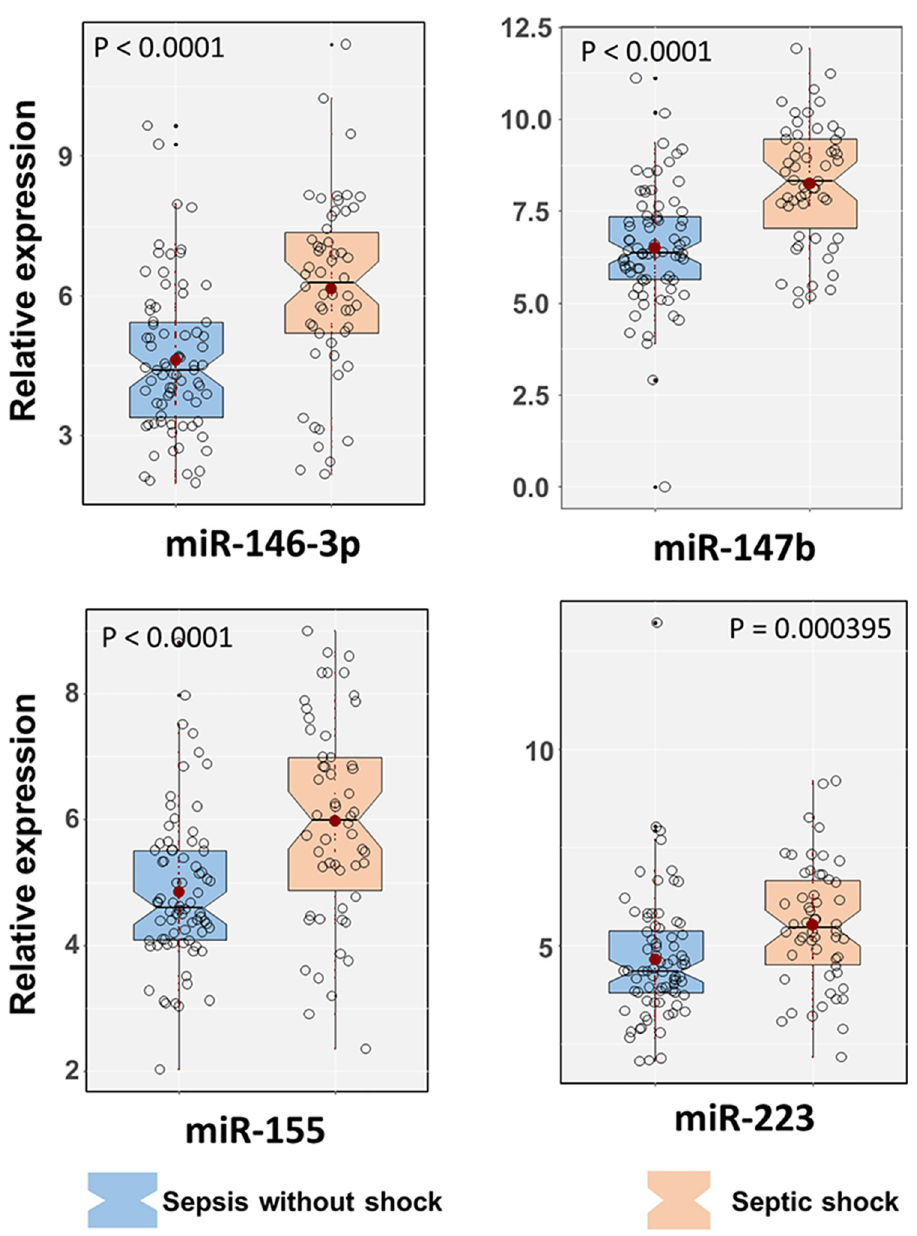
Fig 2. High expression of selected microRNAs is associated with septic shock. Relative expression of individual miRNA (miR-146-3p, miR-147b, miR-155 and miR-223) in sepsis patients with and without shock. P values were calculated by Wilcoxon